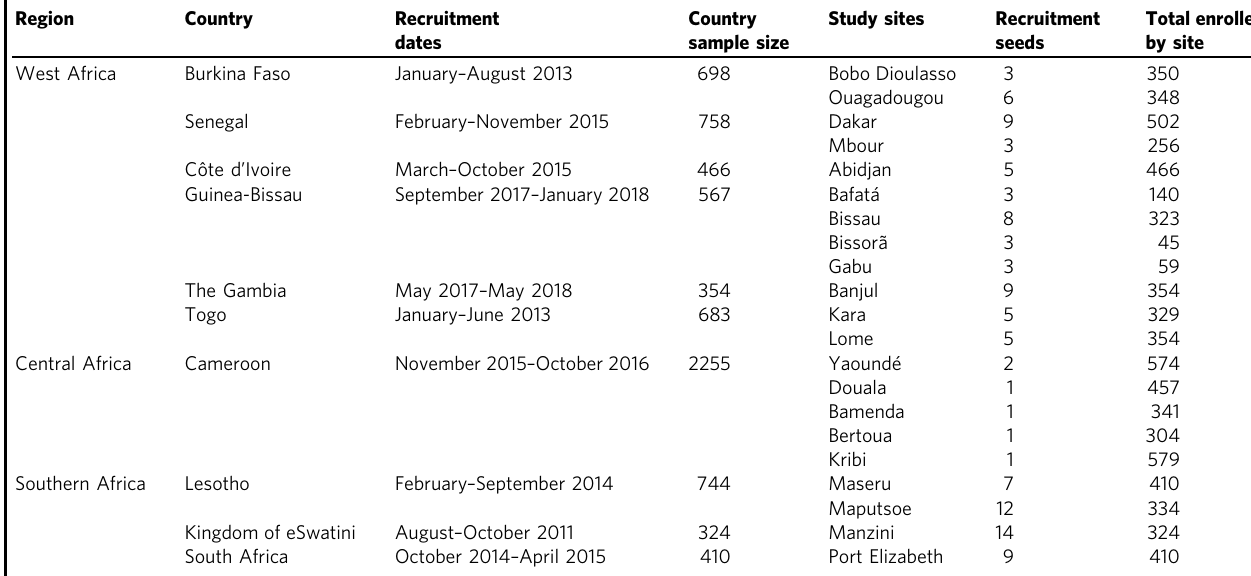
Table 1 Summary of data collection.